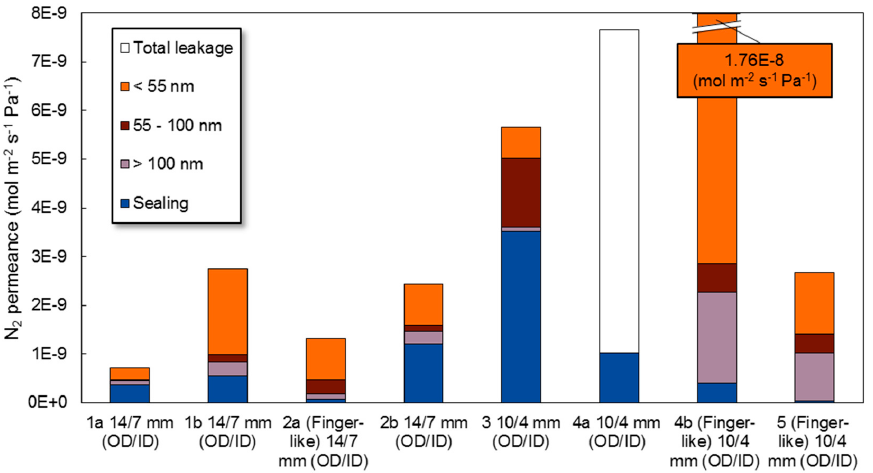
Figure 10. Nitrogen permeance contributions at room temperature, with corresponding pore size contributions.